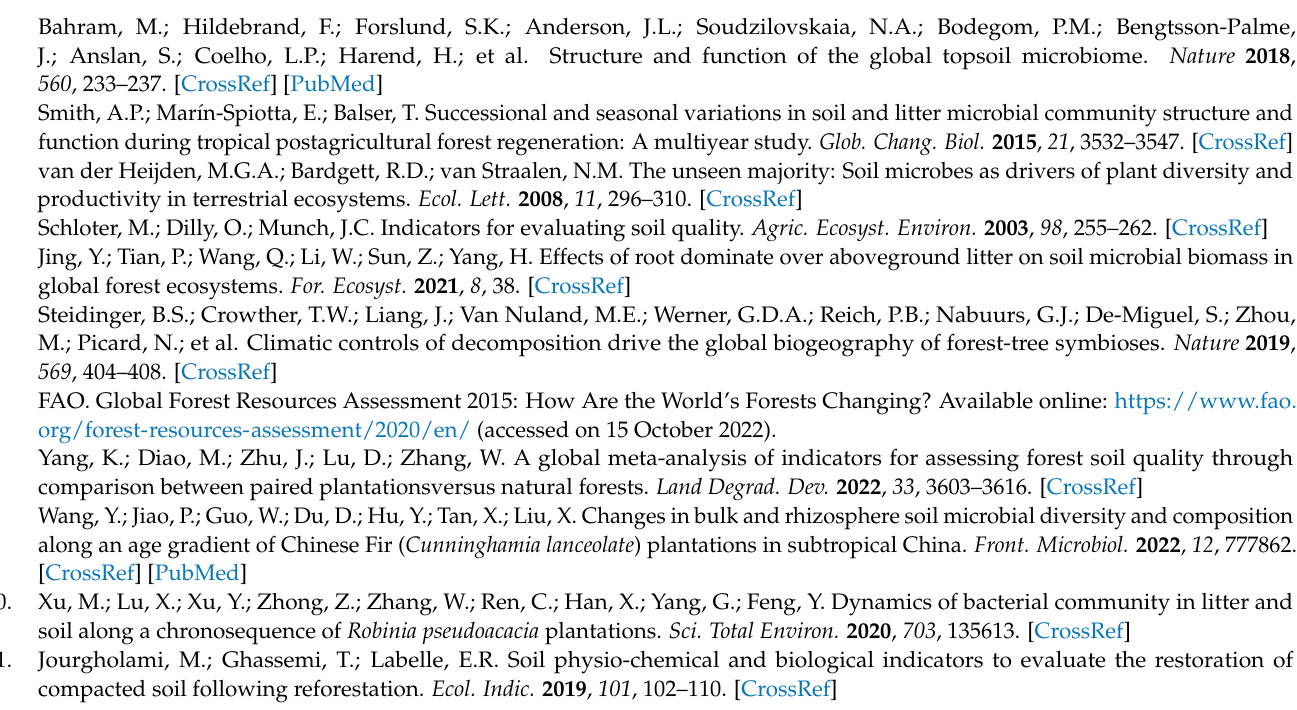
Table S3: Soil physicochemical properties for each stand age in July 2021; Table S4: p value and F value based on a two-way ANOVA for the proportion of functional groups; Figure S1: Correlation analysis of the soil microbial biomass and composition with selected soil physicochemical